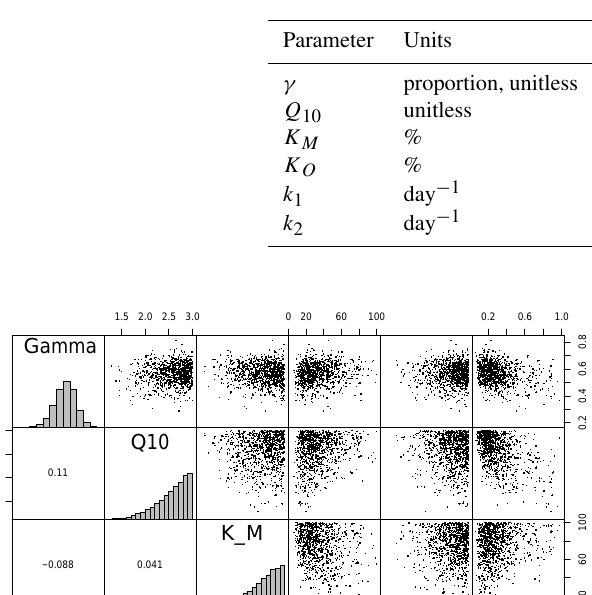
Table 1. Summary statistics of obtained posterior parameter values for the full model of Eqs. (1) and (2) using a Bayesian optimization procedure. Quantiles at 5 and 95% are reported as q 5 and q 95 , respectively.